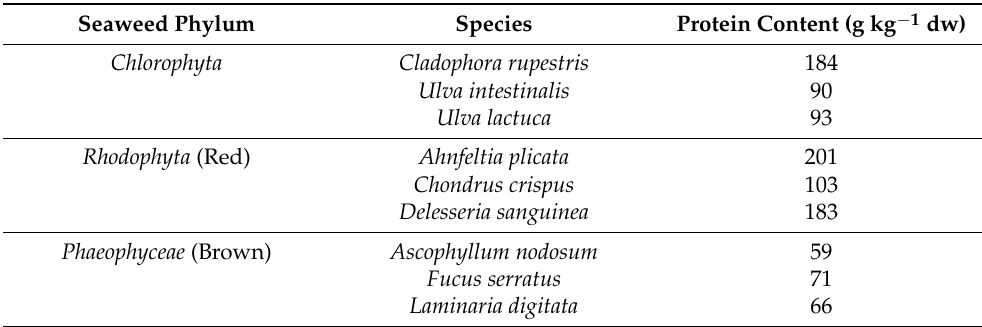
Table 1. Protein content of some red, green, and brown seaweeds on the Swedish west coast, adapted with permission from [8]. 2020, Olsson et al. Seaweed Phylum Species Protein Content (g kg − 1 dw) Chlorophyta Cladophora rupestris 184 Ulva intestinalis 90 Ulva lactuca 93 Rhodophyta (Red) Ahnfeltia plicata 201 Chondrus crispus 103 Delesseria sanguinea 183 Phaeophyceae (Brown) Ascophyllum nodosum 59 Fucus serratus 71 Laminaria digitata 66